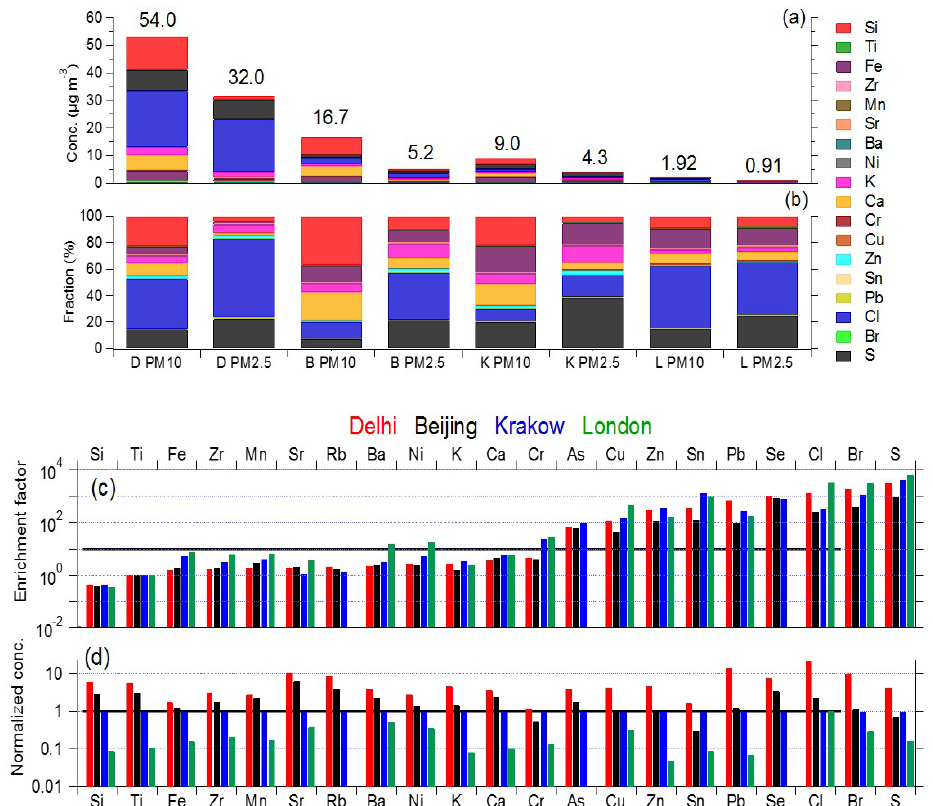
Figure 1. (a) Averaged elemental concentrations and (b) fractions (%) of elements in both size ranges at all four sites: Delhi (D), Beijing (B), Krakow (K), and London (L). (c) Enrichment factors (using Ti as reference) of the measured elements in PM 10 (EF ∼ 10; solid line). (d) Averaged elemental concentrations in PM 10 normalized by those at Krakow. Note that Rb, As, and Se are not included in (a) and (b) because of absence in the London dataset, while all three are considered in (c) and (d) for the comparison between the rest of the sites.